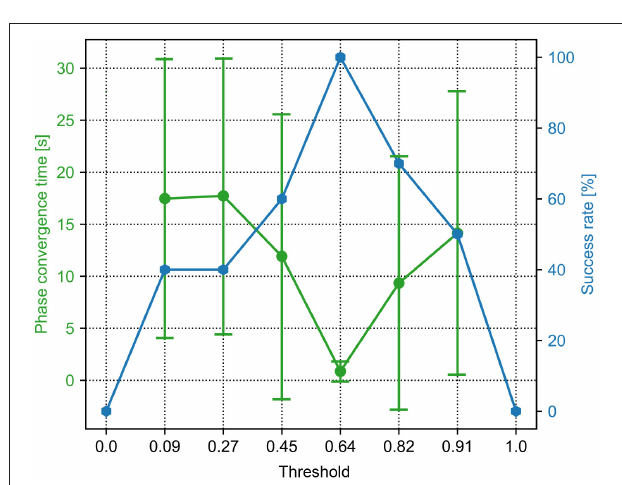
FIGURE 6 | Four different situations that the robot experienced in the experiments. S1 was a normal situation. In S2, the GRFs of the four legs were added with Gaussian noise. In S3, the hip joint and knee joint of the right front leg were fixed to imitate leg damage. In S4, the robot carried a load of